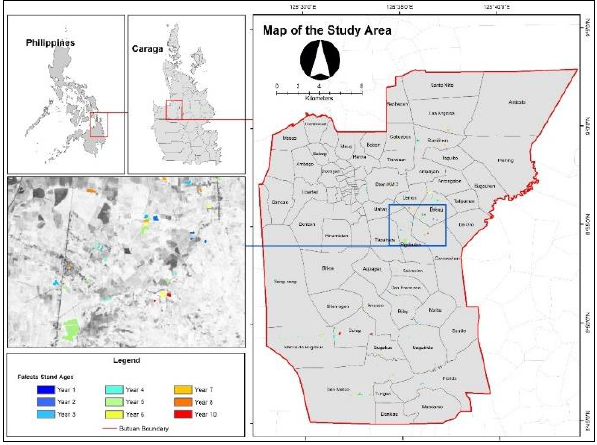
Figure 3 . The study area: Butuan City, Caraga Region, Mindanao, Philippines. Also shown are the locations of model development and machine learning